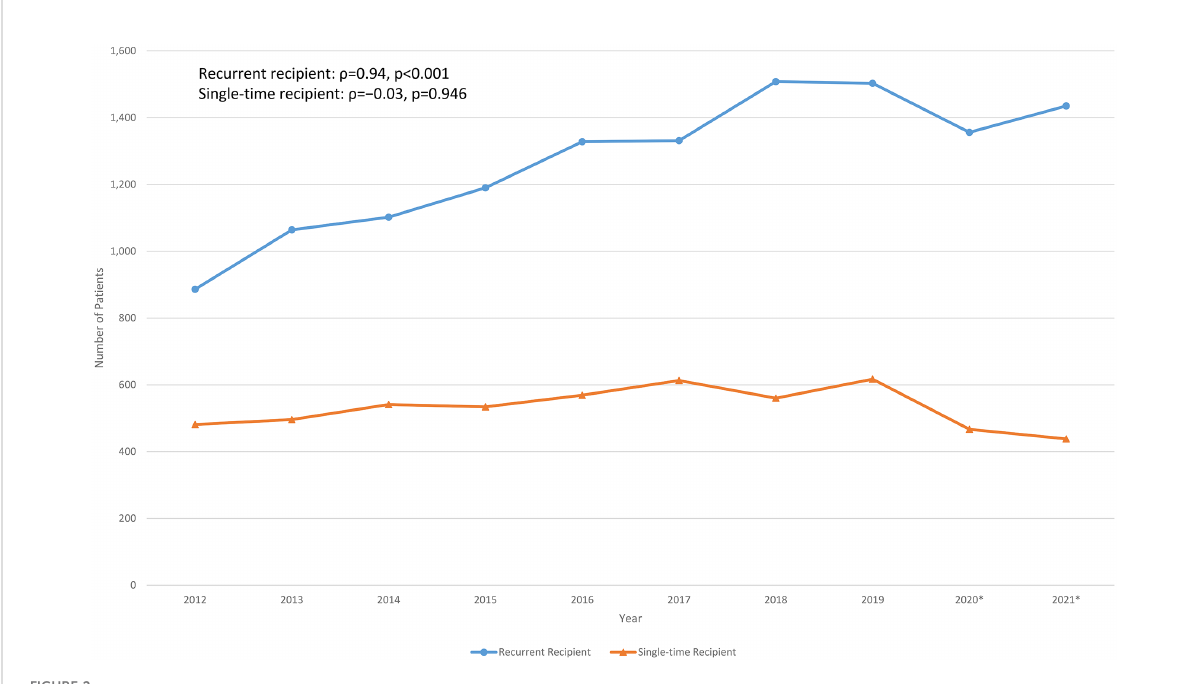
FIGURE 2 Longitudinal recurrent and single-time normal immunoglobulin recipients over the past decade in Hong Kong. *Outbreak of COVID-19 in Hong Kong since January 2020, some of the healthcare services had been temporarily suspended upon waves of